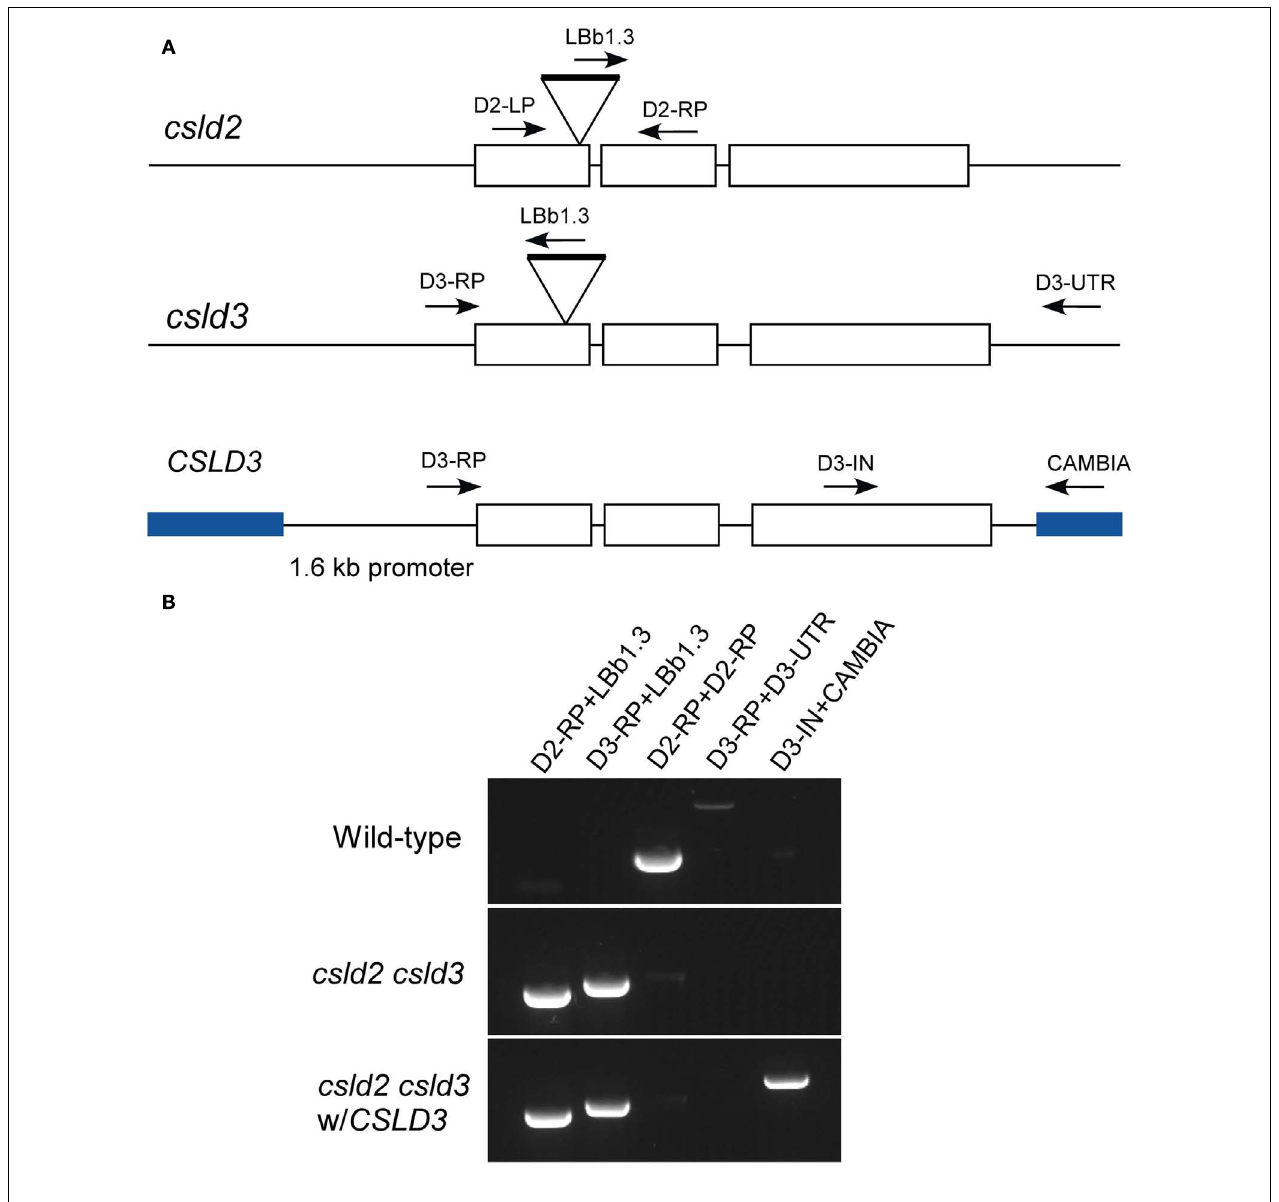
lines.The arrows indicate the position of the primers used for genotyping. (B) Genotyping by PCR using different sets of primers indicated in (A) .The complemented line does not have the native CSLD3 but has the transgenic CSLD3 in the background of csld2 csld3 double